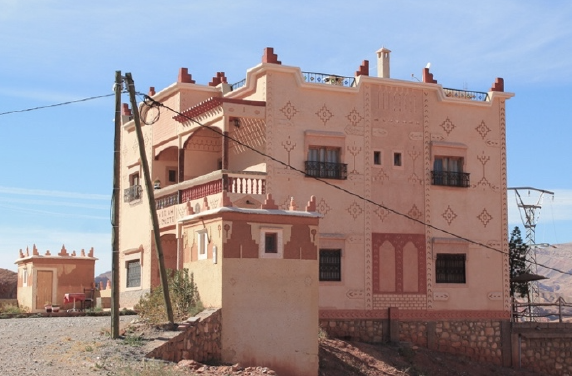
Figure 20. “Kasbah Tialouite”,